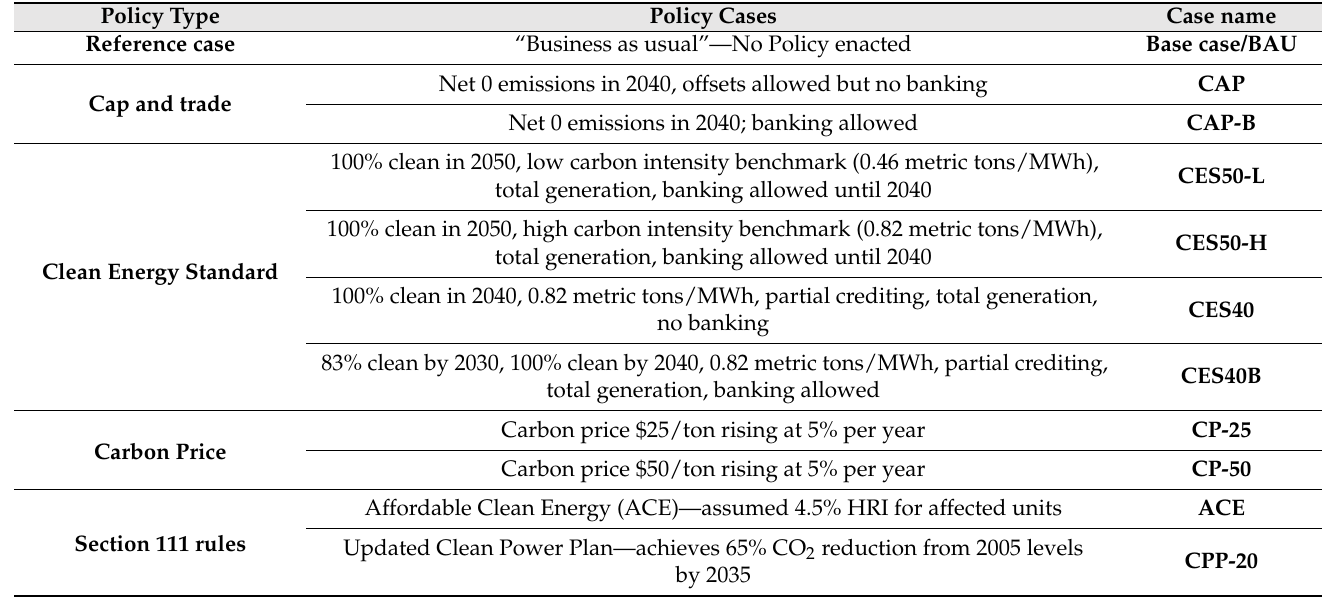
Table 1. List and brief description of scenarios of policy options for decarbonization of the electricity sector used in this